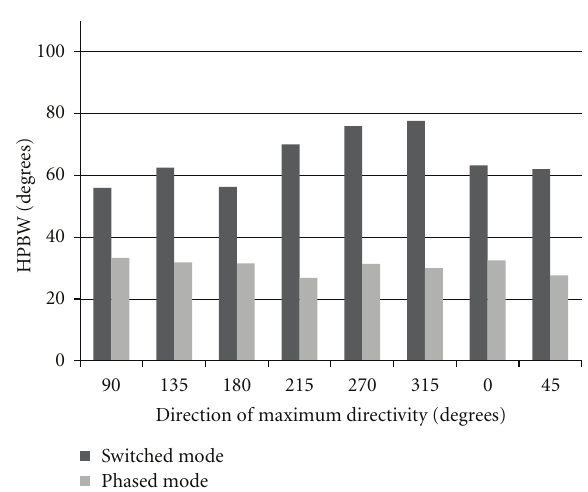
Figure 8: HPBW simulations comparison for the V-shaped antenna array placed over a ground